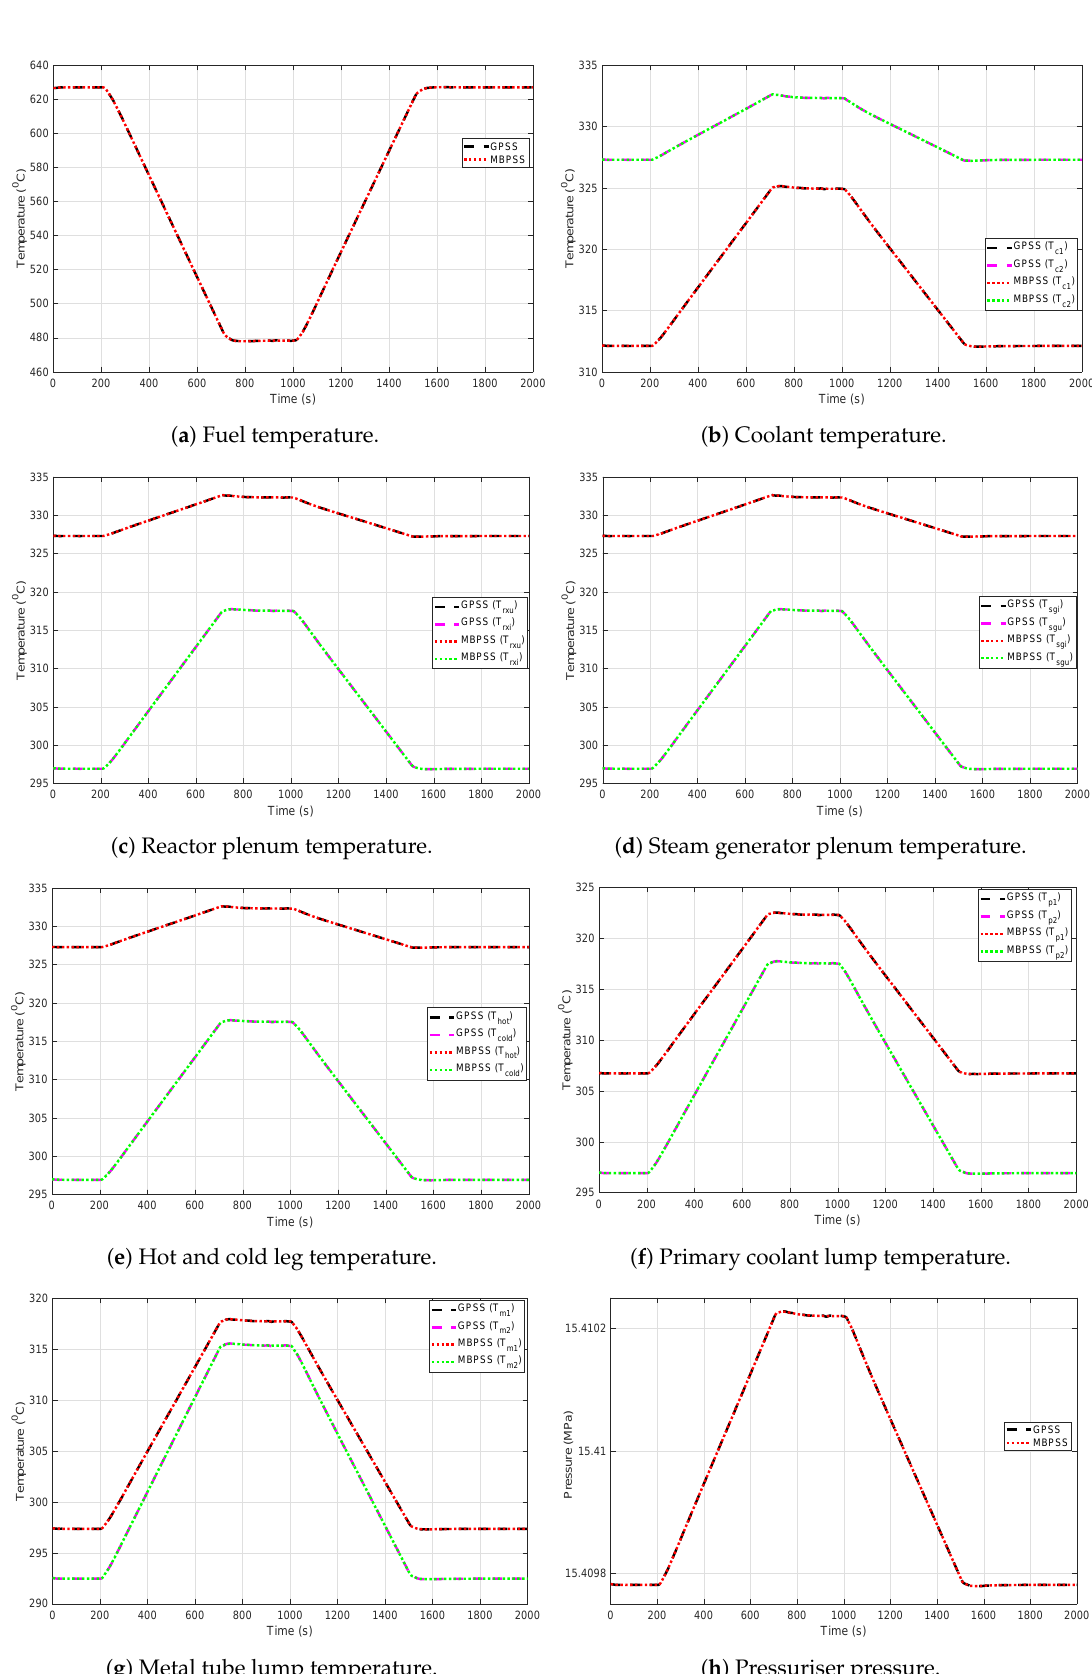
Figure 9. Case I: Variation in nuclear power plant variables following single-phase faults with generic and multiband